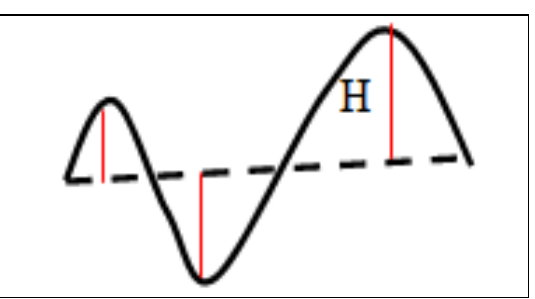
Figure 4. Curvature